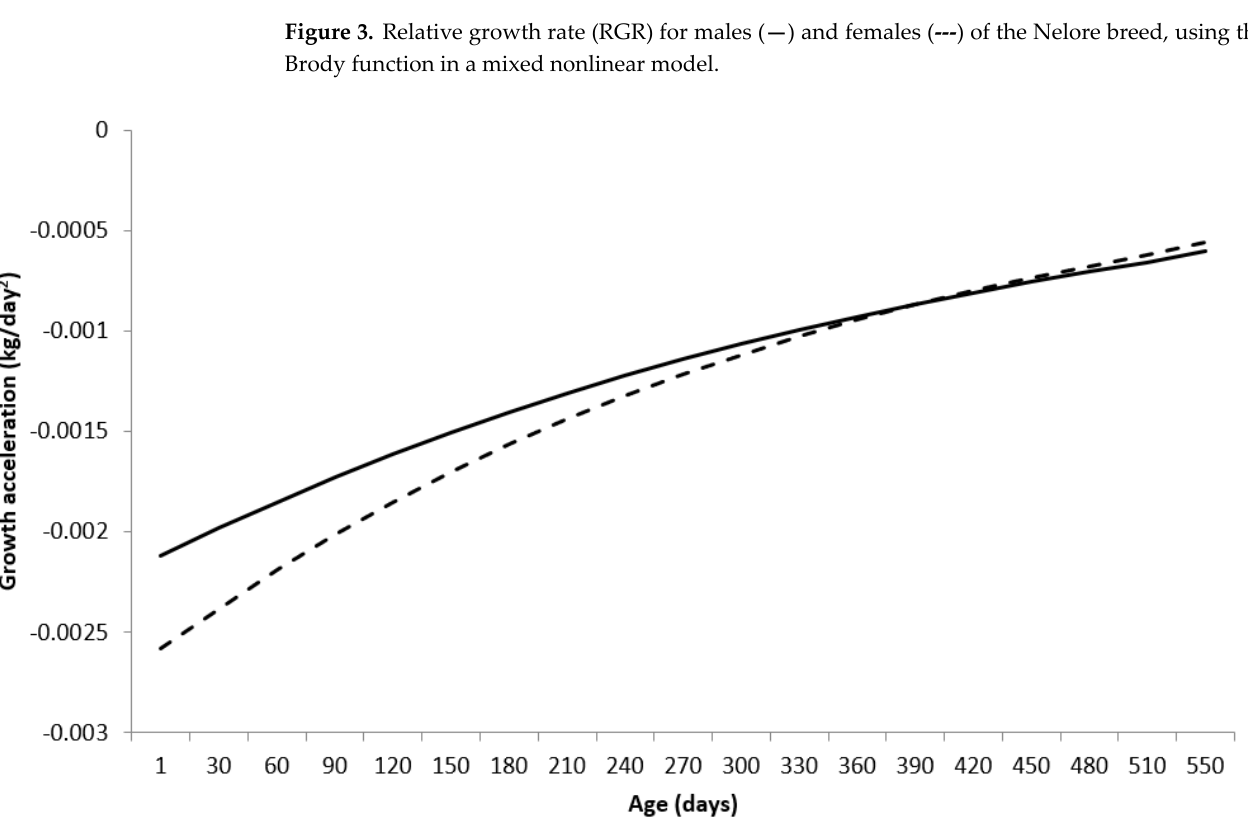
Figure 4. Growth acceleration (GA) for Nelore breed males ( ____ ) and females ( --- ), using the Brody function in a mixed nonlinear model. function in a mixed nonlinear